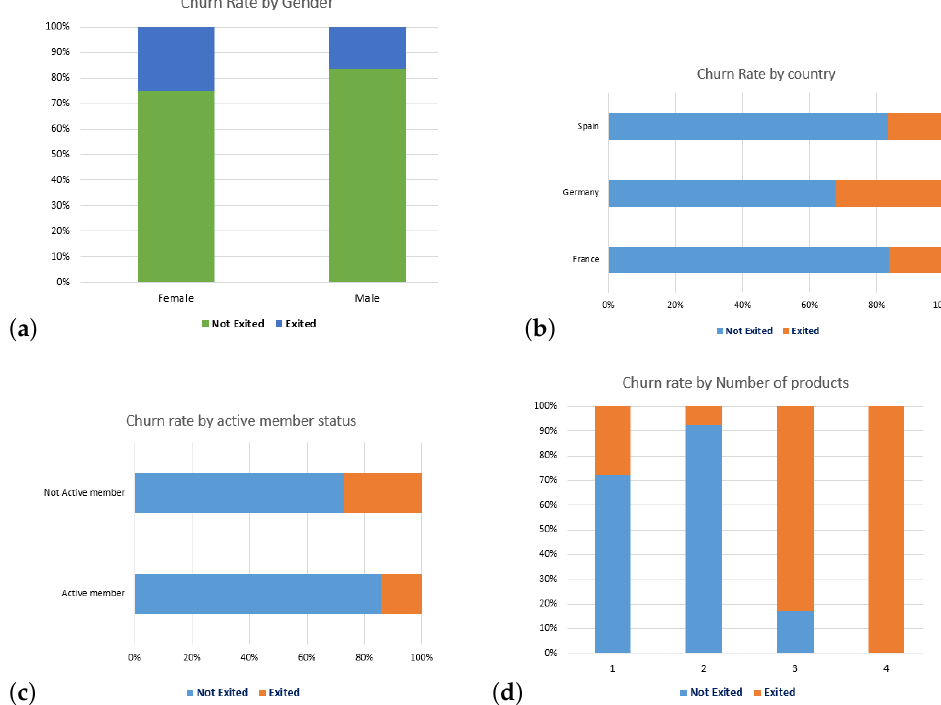
Figure 4. Visualizing the churn rate by ( a ) Gender ( b ) Country, ( c ) Active member status, and ( d ) Number of